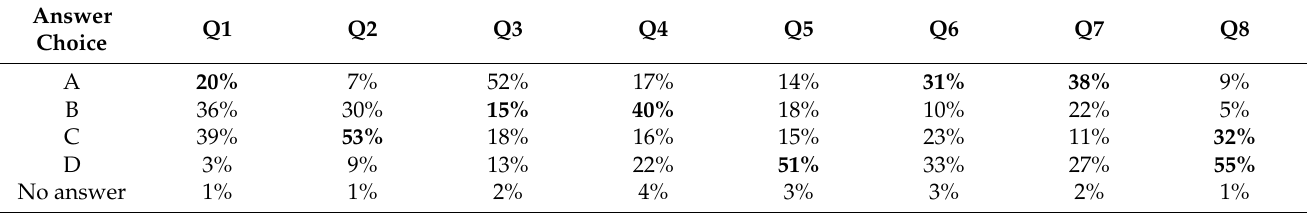
Table 2. Frequencies of N = 176 students’ responses to the QTI. Correct answer choices are in boldface. See Appendix B for the complete